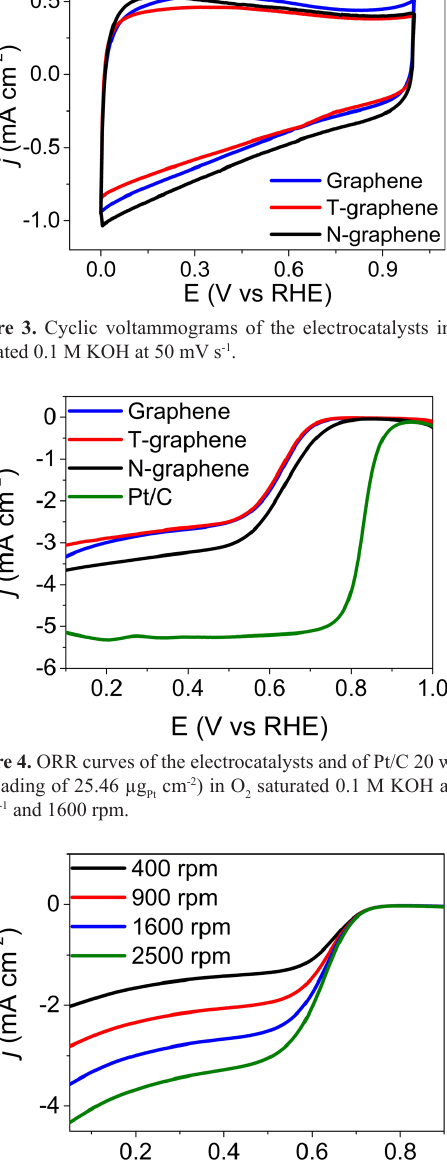
saturated 0.1 M KOH at 10 mV s -1 and Figure 5. ORR curves in O 2 different electrode rotation rates for Graphene T-graphene